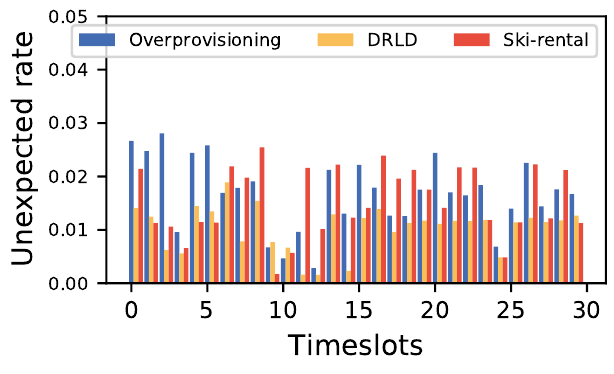
Figure 7. Unexpected rate